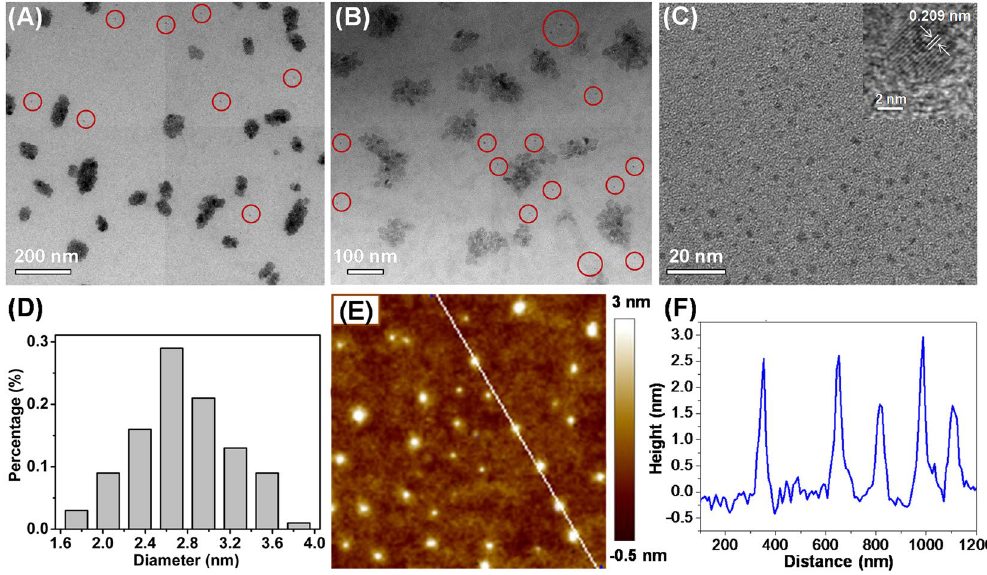
Figure 2. Representative TEM images of the CNDs dispersion, which were generated via hydrothermal treatment of E. prolifera at 150 °C for 3 h ( A ), 180 °C for 3 h ( B ), 180 °C for 6 h ( C ), respectively. HRTEM image (inset of C ), the particle size distribution calculated based on TEM image ( E ), AFM topography image on silicon substrate, ( E ) and corresponding height profile, ( F ) of the CNDs prepared via hydrothermal treatment of E. prolifera at 180 °C for 6